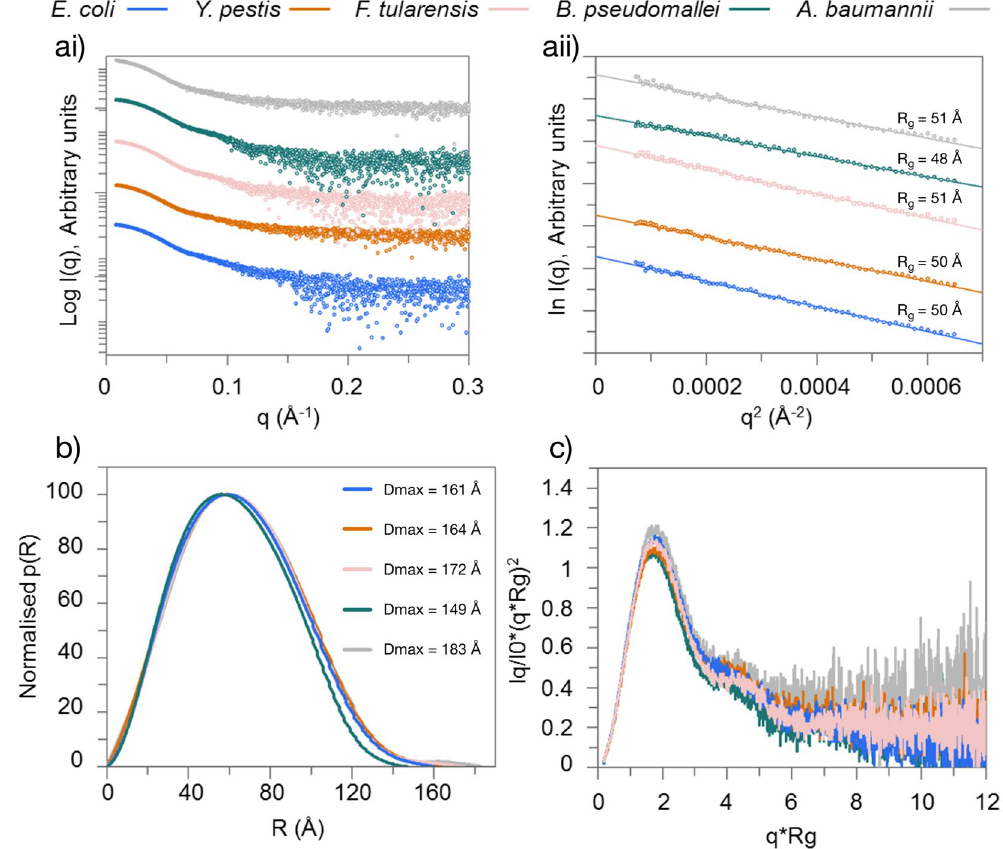
Figure 3. SAXS data and analysis for RNase E NTDs. ( ai ) Radially averaged scattering data for E. coli , Y. pestis ., F. tularensis , B. pseudomallei and A. baumannii RNase E NTDs. Data have been plotted using an offset for visualisation purposes. ( aii ) Guinier region of the scattering data shown in ai for each of the RNase E NTDs together with fits and the derived R g values. Data have been plotted using an offset for visualisation purposes. ( b ) Distance distribution p(R) plots for each of the RNase E NTDs together with the derived D max values. Each plot has been normalised to the maximum p(R). ( c ) Dimensionless Kratky plots for each of the RNase E NTDs.